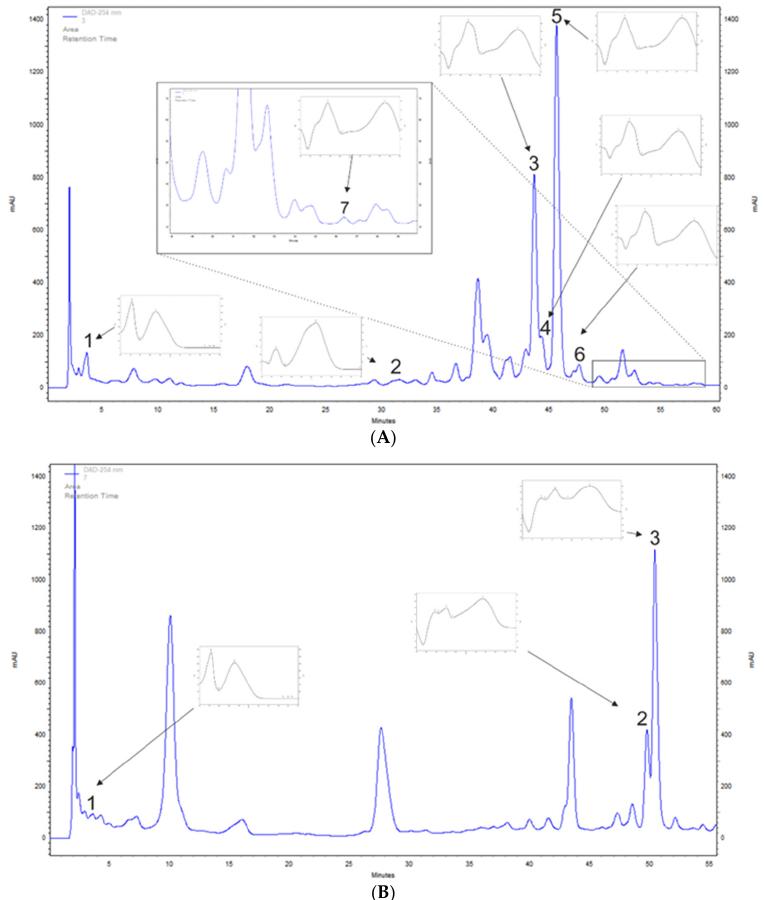
Figure 1. Examples of high-performance liquid chromatography–diode array detection (HPLC-DAD)-based separation ( λ = 254 nm) of leaf extracts of ( A ) Acacia saligna : 1, gallic acid; 2, p -coumaric acid; 3, hyperoside; 4, quercetin 3-glucuronide; 5, rutoside; 6, isoquercetin; 7, quercetin; and ( B ) Lawsonia inermis: 1, gallic acid; 2, apigenin 5-glucoside; 3, apigetrin. Table 1. Polyphenol contents of A. saligna and L. inermis leaf extracts (mg/100 g dry weight (DW) ± SD).